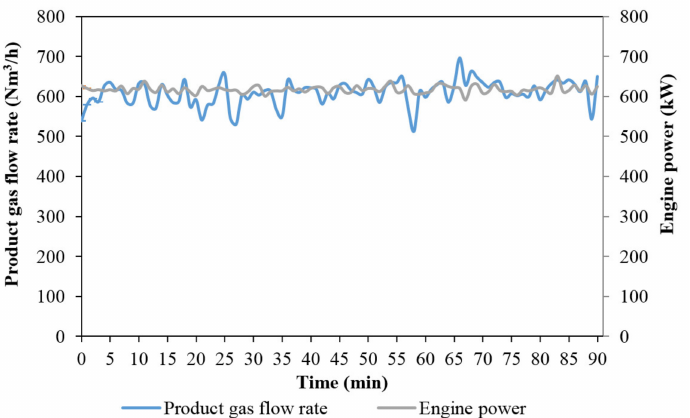
Figure 14. Product gas flow to the engine and engine power